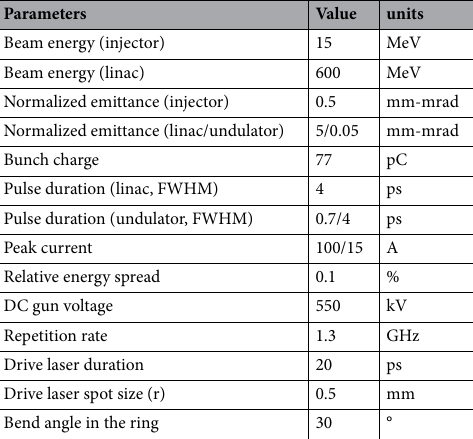
Table 1. Beam parameters in the injector, linac and recirculating loop.